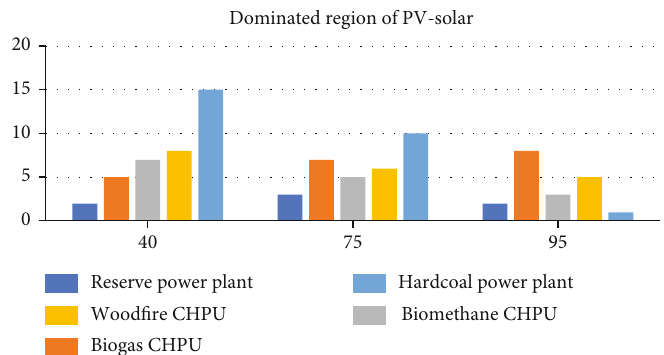
Figure 5: Coverage of the fl eet ’ s low residual demand by various facilities or EESS. Table 2: After addressing the residual load, the remaining extra energy and power. Region Share of renewables Excess of annual energy Excess of maximum power Dominated region of PV solar